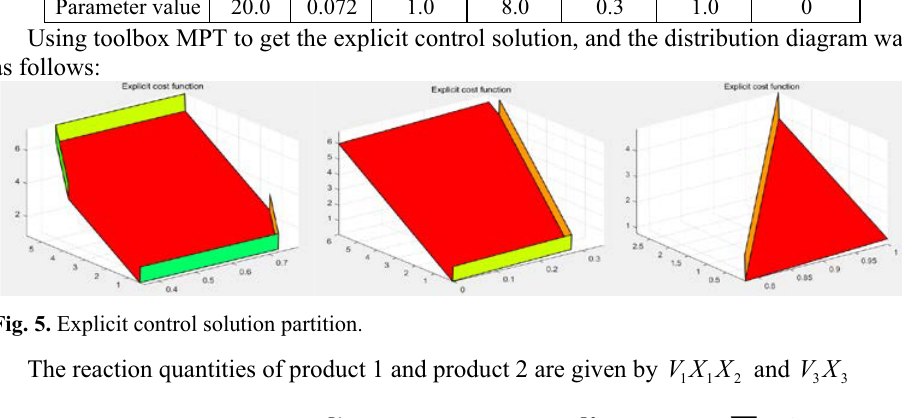
Table 4. Pure scheduling select product status delivery